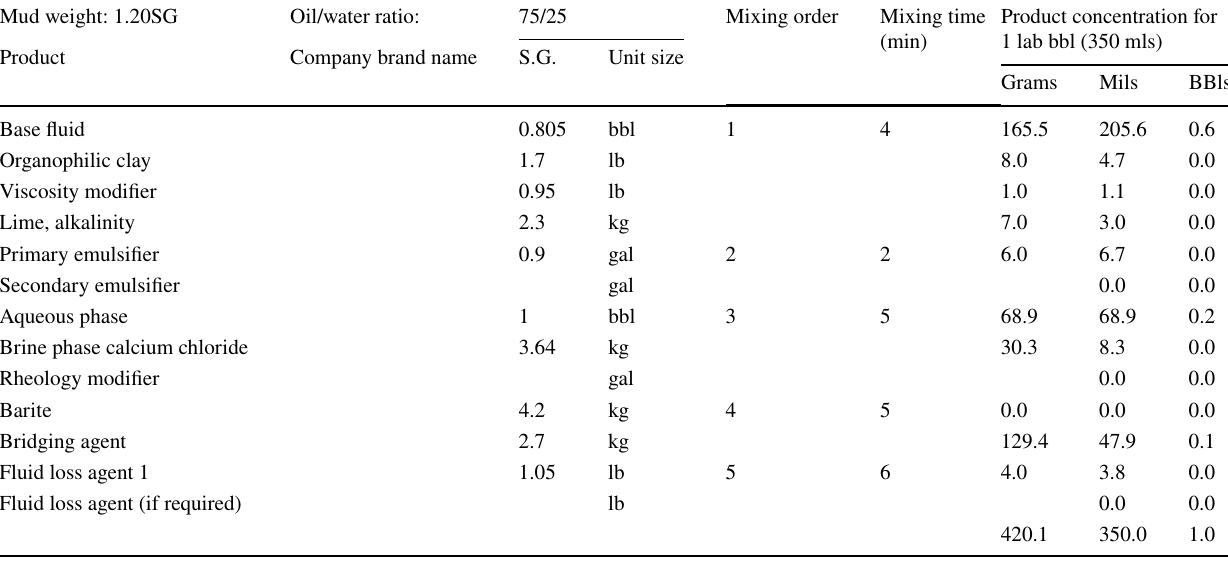
Table 2 Oil-based mud systems (non-aqueous) formulation Mud weight: 1.20SG